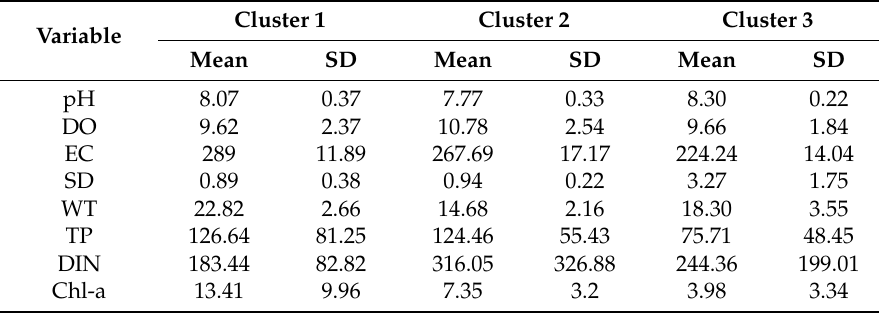
Table 4. Statistical description of the SOM’s clusters found using the hierarchical algorithm method, based on mean values and standard deviation